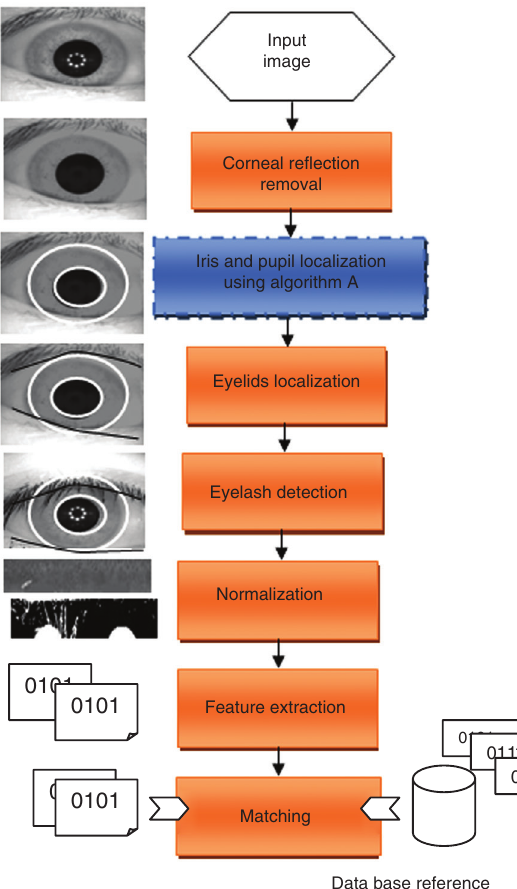
Figure 2. Flowchart of the Proposed Iris Recognition